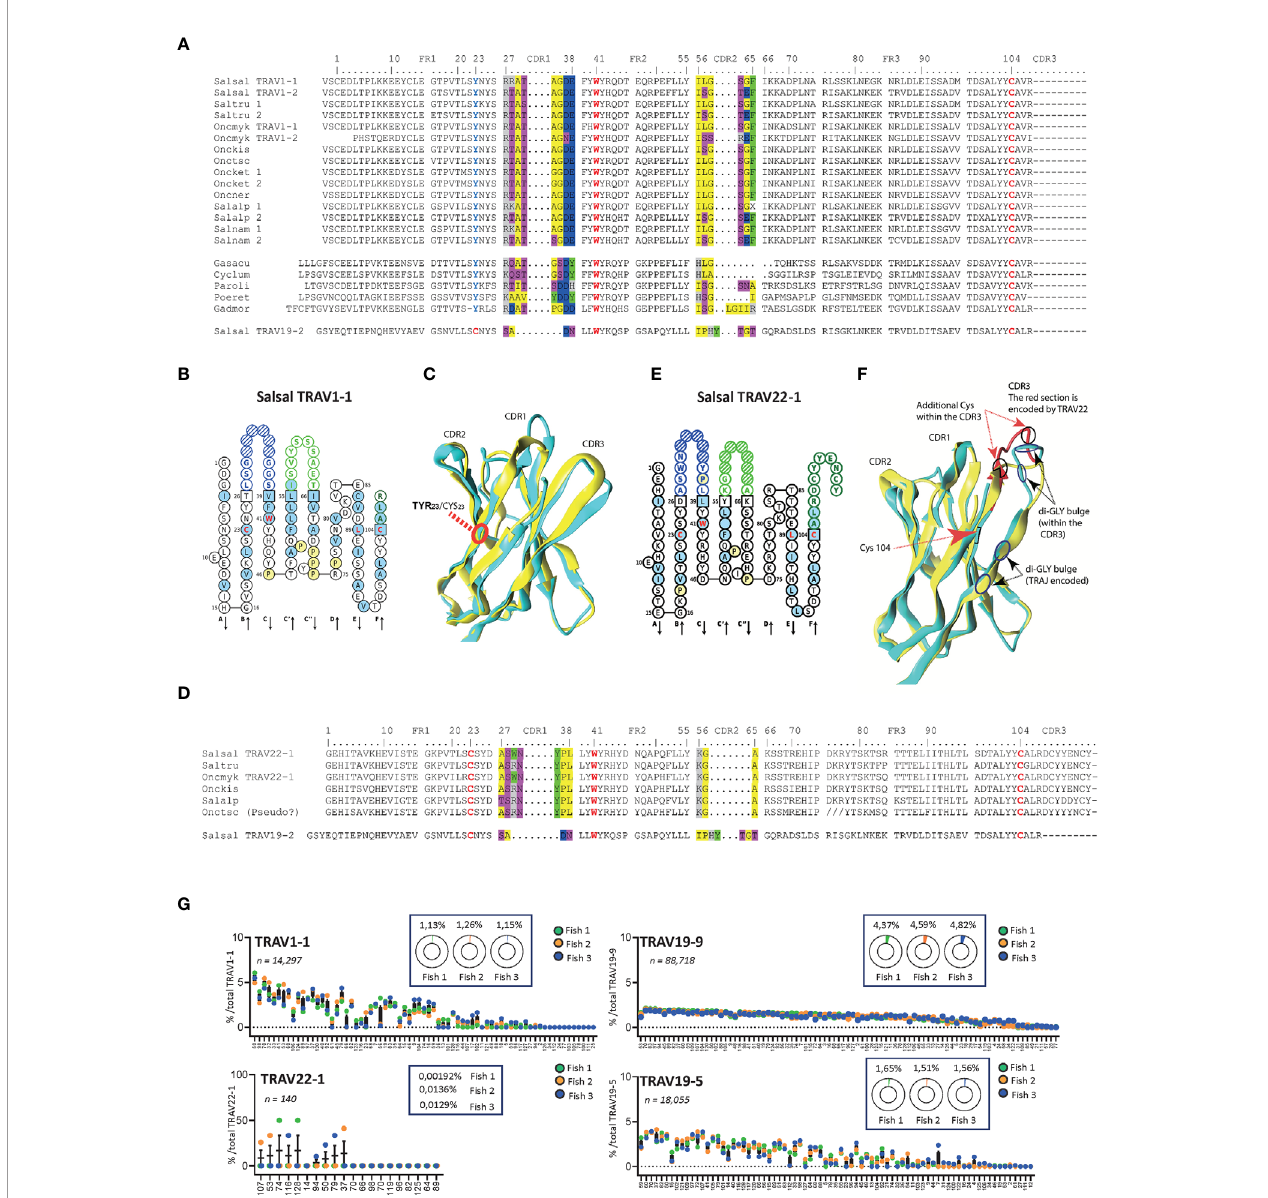
FIGURE 5 | Speci fi c features of salmonid TRAV1 and TRAV22. (A) . Multiple alignment of TRAV1 protein sequences from Atlantic salmon (Salsal) and rainbow trout (Oncmyk) with sequences presenting similar features from other Salmonids and other teleost. (B) IMGT Collier de Perles representation of Atlantic salmon TRAV1-1 based on the IMGT unique numbering for V-DOMAIN (45, 46). CDR1-IMGT is shown in dark blue and the CDR2-IMGT in light green and the germline CDR3-IMGT in dark green (33). Amino acids are shown in the one-letter abbreviation. Hatched circles correspond to missing positions according to the IMGT unique numbering (33, 46). (C) Salmon TRAV1 domain (cyan) aligned to human TR 2w20 alpha chain V domain. Position 23 is frame in red. (D) Multiple alignment of TRAV22 protein sequences from rainbow trout and Atlantic salmon with related sequences from other salmonids. (E) IMGT Collier de Perles of Atlantic salmon TRAV22-1. (F) Salmon TRAV22 domain (cyan) aligned to human TR lpha chain V domain. Note the long CDR3. The section of CDR3 encoded by TRAV22 is in red. 2nd-CYS104, additional Cys within the CDR3 loop, and Gly amino acids in di-Gly motifs (one in the G strand and one in within the CDR3) are highlighted. (C, G) Relative TRAJ usage shown as percentage of total reads containing a speci fi c TRAJ gene among TRAV1-1, TRAV22, TRAV19-5 or TRAV19-9 containing productive rearrangements. Individual TRAJ genes are shown on the X-axis, average number of reads from each fi sh containing the indicated TRAV-TRAJ combination are shown ( fi sh 1 is in green, fi sh 2 in orange and fi sh 5 in blue). The total number of sequences for each TRAV is indicated and the inlaid box shows the average representation of each TRAV per total number of productive rearrangements from each fi sh. (Atlantic salmon, Salmo salar : Salsal; rainbow trout, Oncorhynchus mykiss : Oncmyk; Brown trout, Salmo trutta : Saltru; Coho salmon, Oncorhynchus kisutch : Onckis; Chinook salmon, Oncorhynchus tshawytscha Onctsh; Chum salmon, Oncorhynchus keta : Oncket; Sockeye salmon, Oncorhynchus nerka : Oncner; Artic char, Salvelinus alpinus : Salalp; Lake trout, Salvelinus namaycush : Salnam; Three-spined stickleback, Gasterosteus aculeatus : Gasacu; Lump fi sh, Cyclopterus lumpus : Cyclum; Olive fl ounder, Paralichthys olivaceus : Paroli; goby, Gobiodon reticulatus : Gobret, and Atlantic cod, Gadus morhua : Gadmor; guppy, Poecilia reticulata Poeret; sea bass, Dicentrarchus labrax : Diclab; barramundi perch, Lates calcarifer :